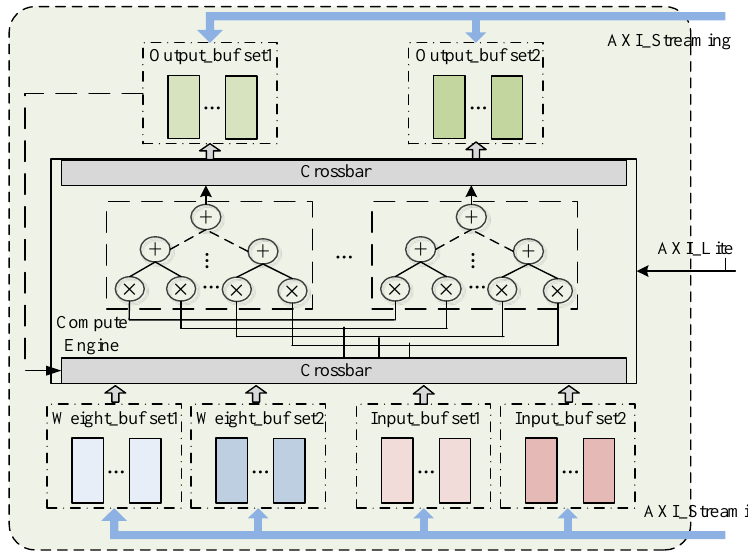
Figure 4. Structure of FPGA accelerator.